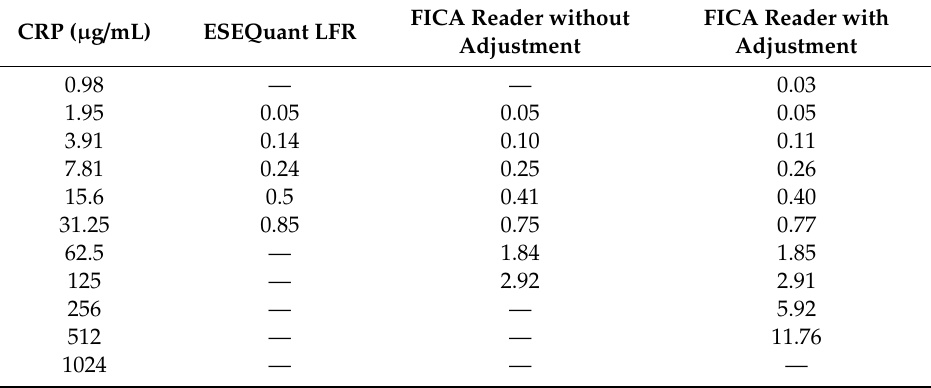
Table 1. Comparison of detection ranges of C-reactive protein (CRP) solution between the ESEQuant Lateral Flow Reader (LFR) and the FICA reader after automatic range adjustment.